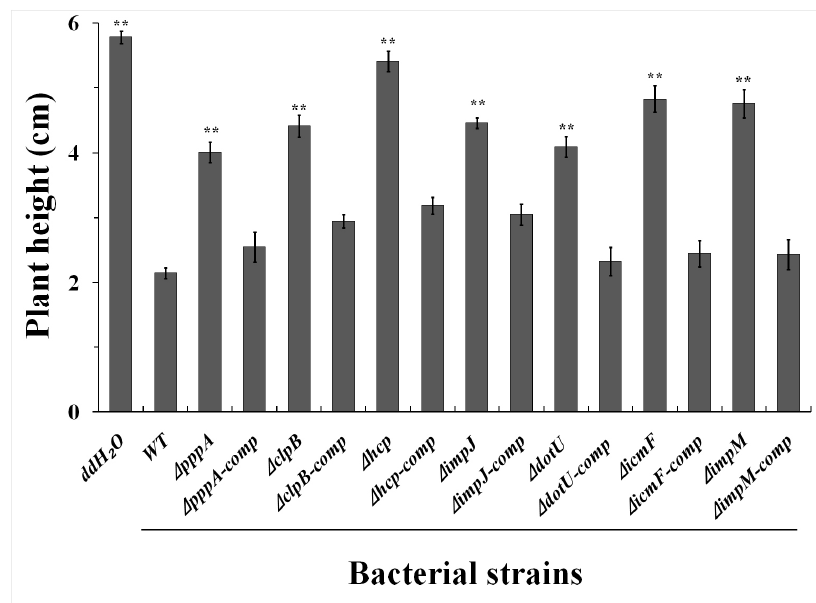
Figure 5. The effect of T6SS genes of Acidovorax avenae subsp. avenae strain RS-2 on virulence phenotype in respect of plant height for the rice seedling. WT: wild-type strain RS-2; ddH 2 O: double distilled H 2 O; ∆ pppA/ ∆ pppA -comp: